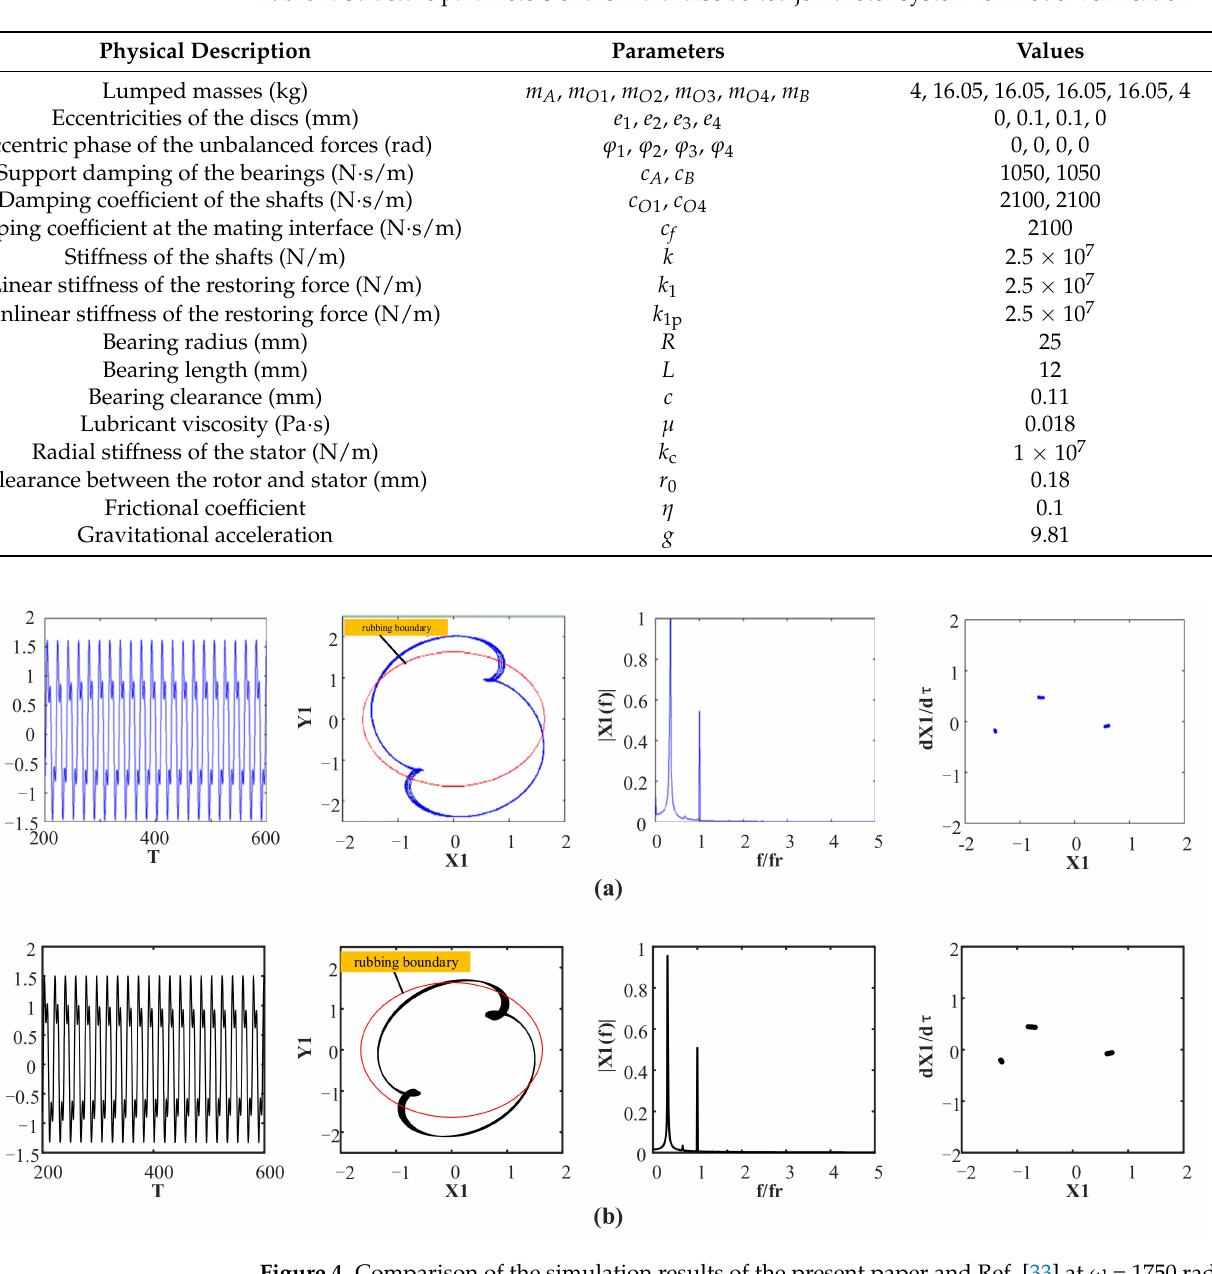
Table 1. Structure parameters of the multi-disc bolted joint rotor system for model verification.